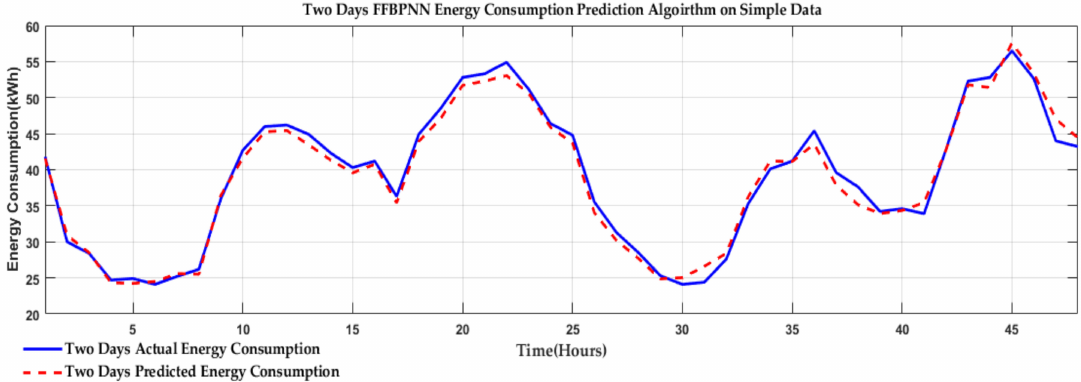
Figure 9. One day hourly energy consumption prediction using feed forward back propagation neural network (FFBPNN) on simple data.